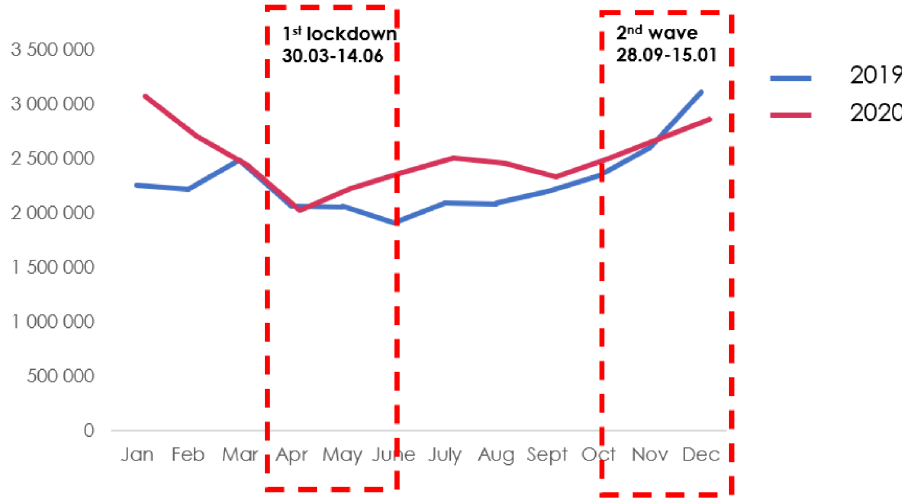
Figure 3. Search dynamics of interest in TOP-20 luxury brands on the Russian market in 2019 and 2020 by month. Source: compiled by authors according to Yandex WordStat . Comparison of